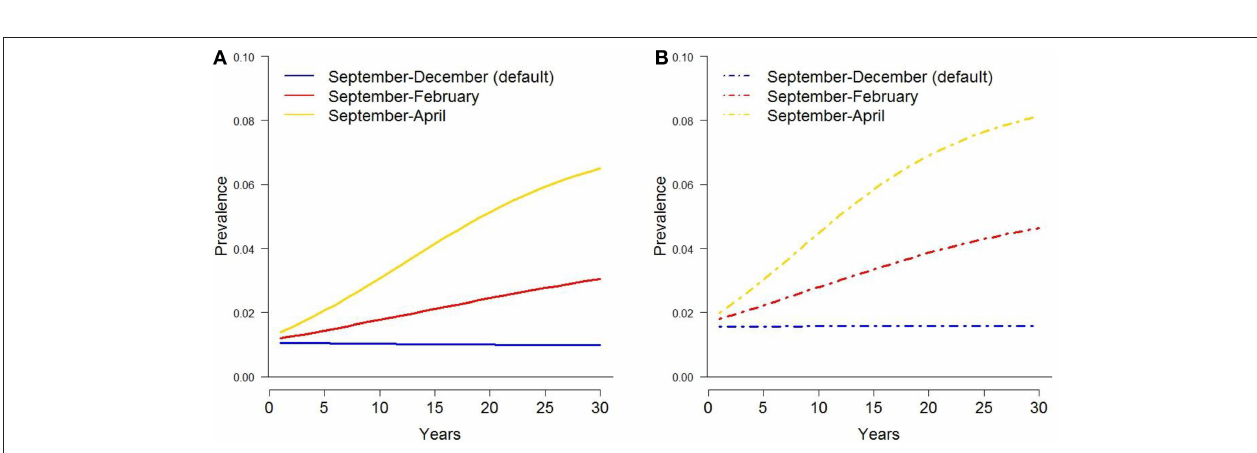
FIGURE 2 | Tuberculosis prevalence in white-tailed deer over 30 years under different probabilities of deer movement to a supplemental food pile, assuming original (A) and current (B) harvest rates.